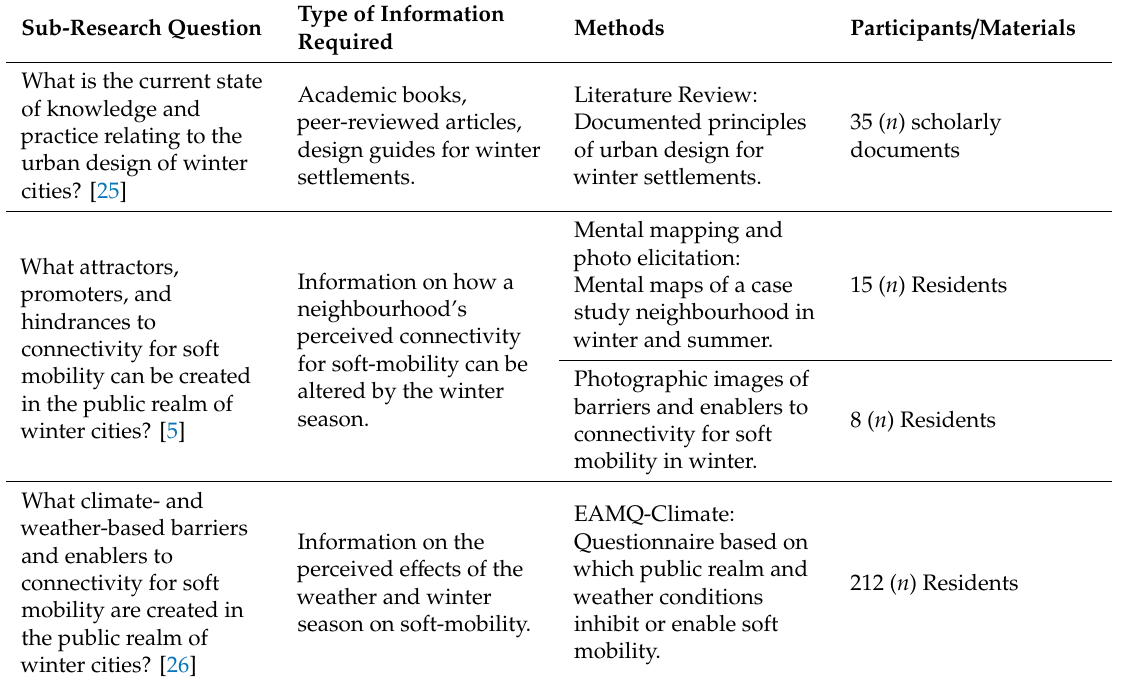
Table 1. Schedule of sub-research questions, methods, and